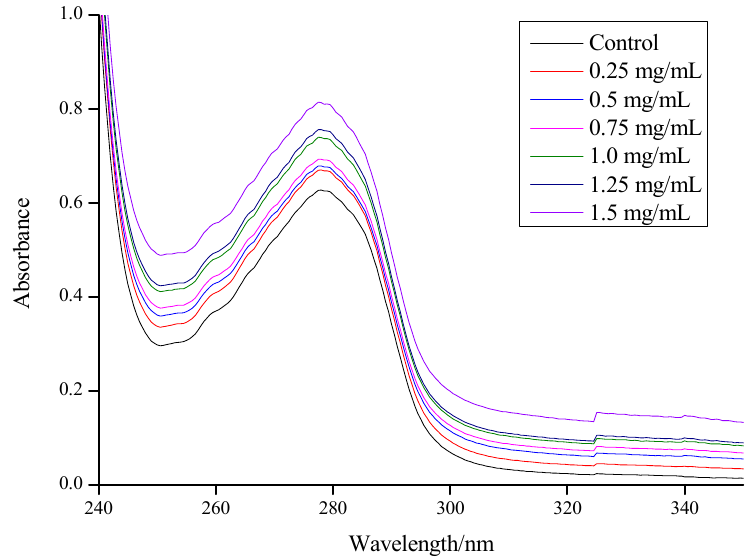
Figure 3. UV adsorption spectroscopy of BSA and gradient concentrations of CSNP solution mix-